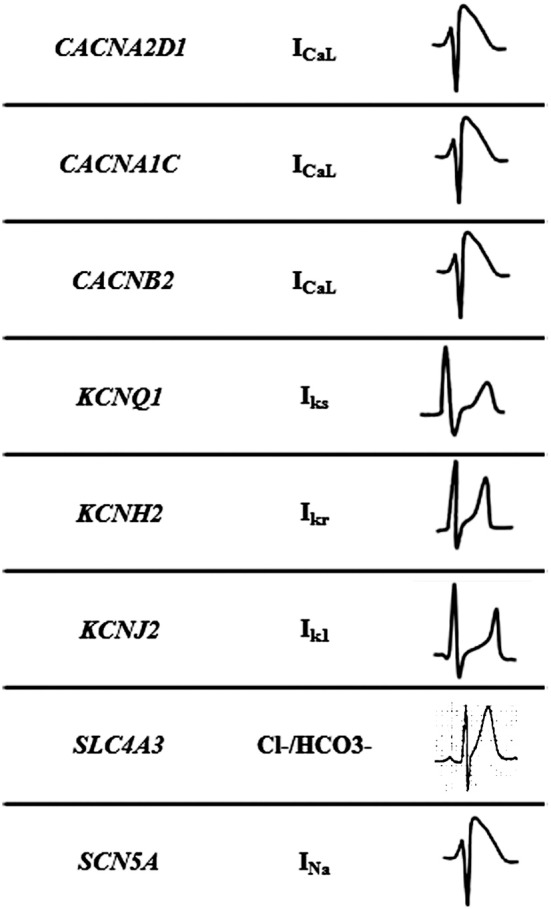
Mechanisms of Short QT syndrome. Gain-of-function mutations of potassium and loss of- function mutations of calcium and sodium channels result in an abbreviated repolarisation phase during action potential and shortening of the QT interval.